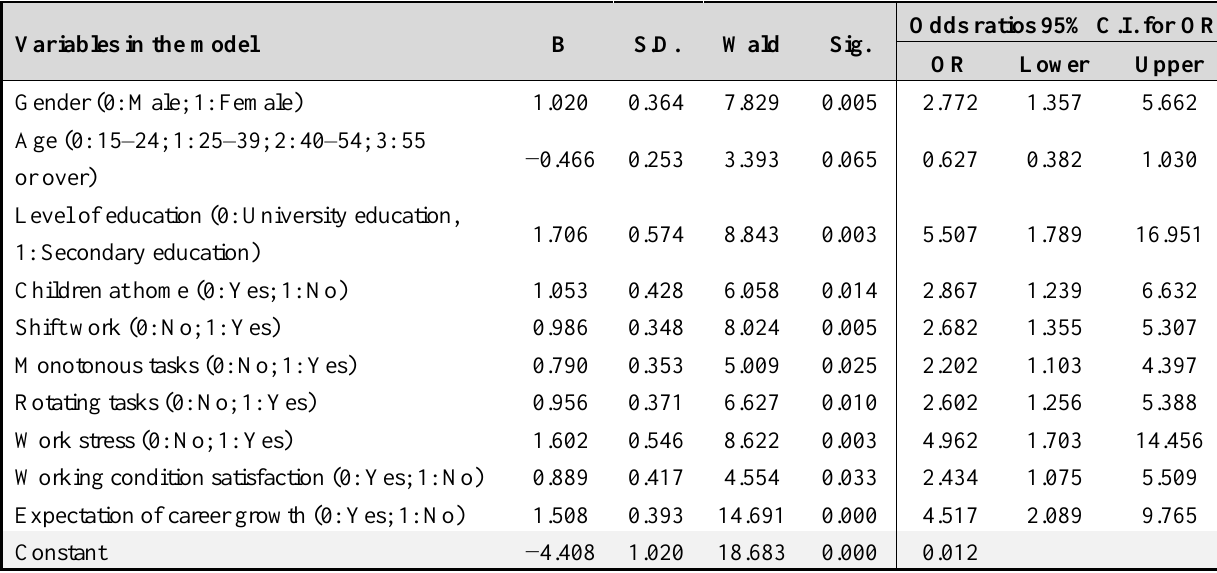
Table 2. Logistic regression for factors that may determine workplace bullying (confidence intervals for odds ratios).